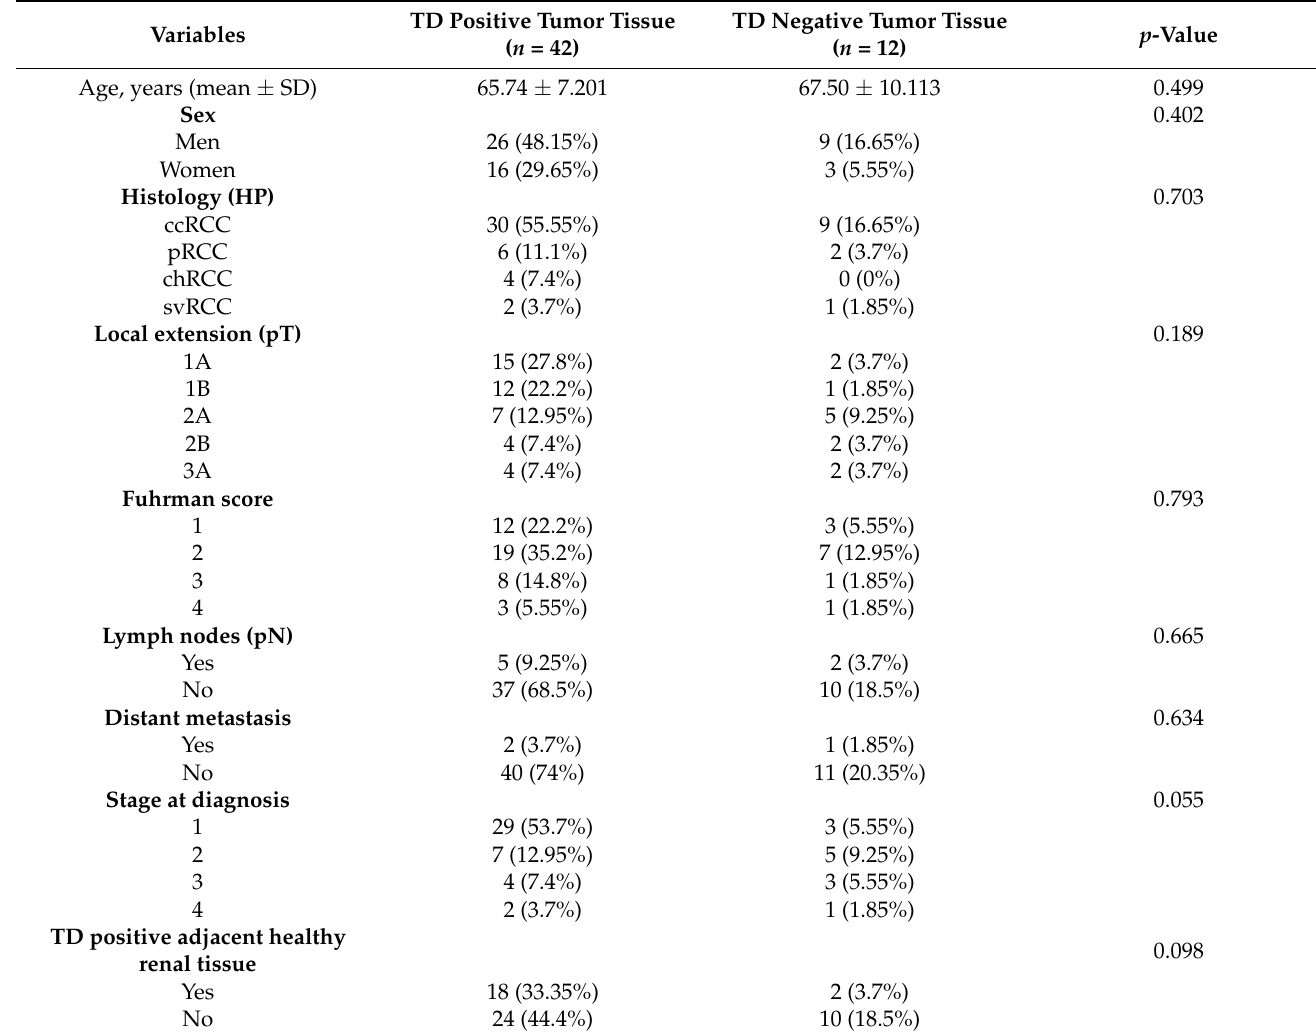
Table 2. Comparison of patient characteristics stratified by the presence of thymine dimer staining in the tumor tissue of evaluated RCC